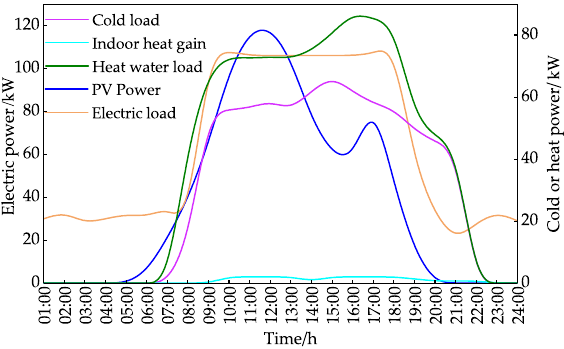
Figure 4. Photovoltaic (PV) generation and load